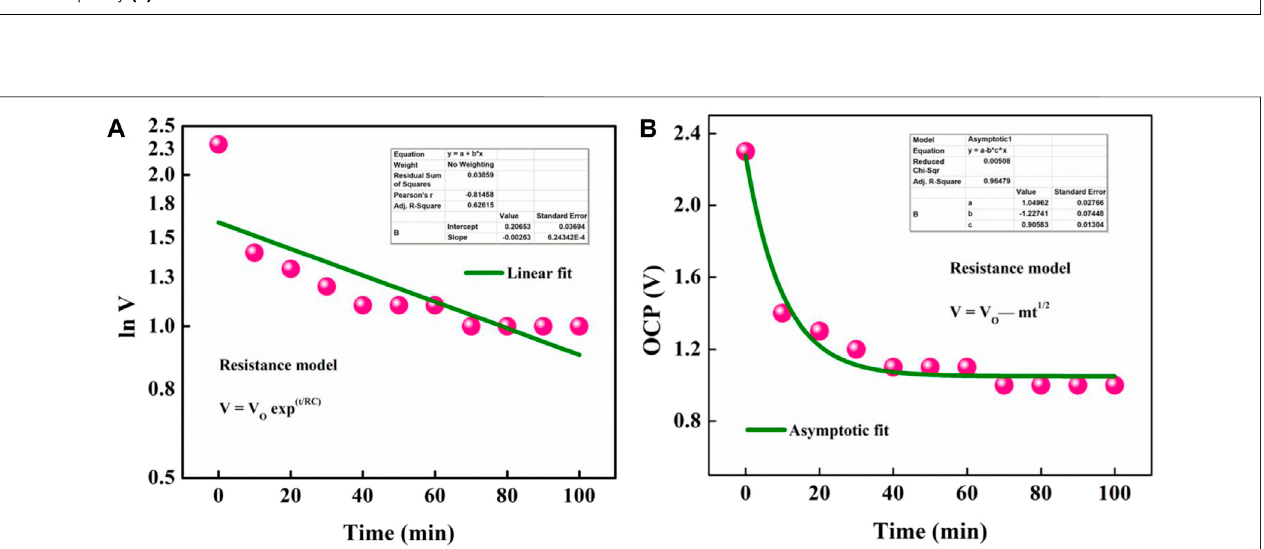
FIGURE 11 | Fitting self-discharge of the cell with current leakage over a resistance model (A) and diffusion-controlled process (B) .